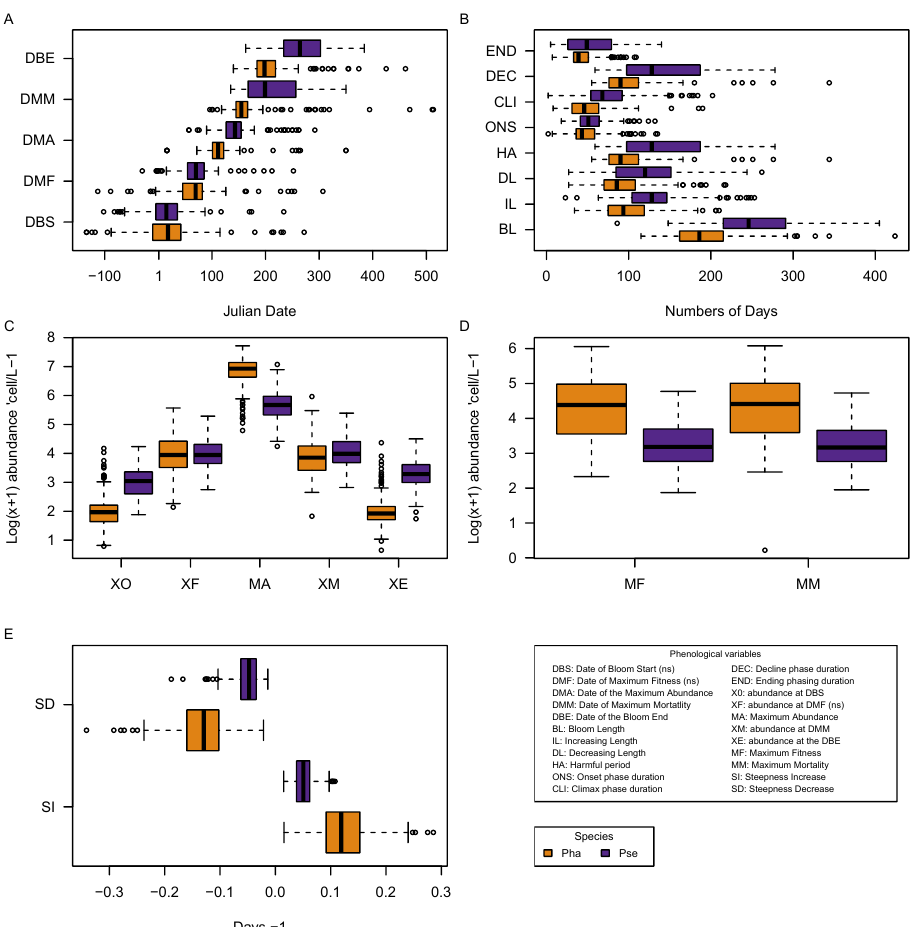
Figure 6. Boxplot summarizing the variations of the different phenological variables for the complex Pseudo-nitzschia (Pse) in purple and for Phaeocystis globosa (Pha) in orange. The middle bars in the boxes represent the median (second quartile); the end boxes are the first and third quartile limiting the middle half of the distribution of the variable; and the dotted line is the data statistical dispersion, calculated as 1.5 times the interquartile distance. Points beyond the dotted lines are possible outliers. ( A ) groups the summary of the dates for the different bloom stages according to the temporal continuum. ( B ) illustrates the variations in day length of the 5 different bloom stages, as well as the bloom increasing and decreasing phase with the total length. ( C ) shows the differences in abundance for each date of the bloom stages. ( D ) confronts the variations of Maximum Fitness and Mortality. ( E ) shows the variations in the bloom steepness. The phenological variables with (ns) in the legend are the ones which were not significant during the species comparison with the Kruskal–Wallis Rank Sum